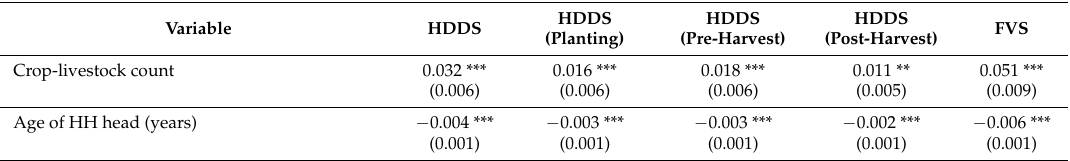
Table A1. Determinants of food consumption diversity in Chamwino (Production diversity indicator used: crop-livestock